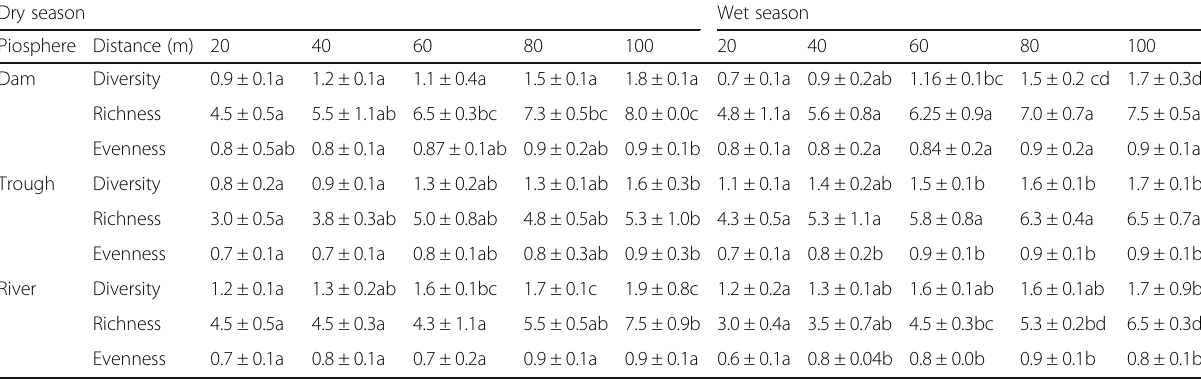
Table 3 Plant species Shannon-Wiener diversity index, richness, and Pielou evenness (mean ± SE) at various piospheric distances Dry season Wet season Piosphere Distance (m)